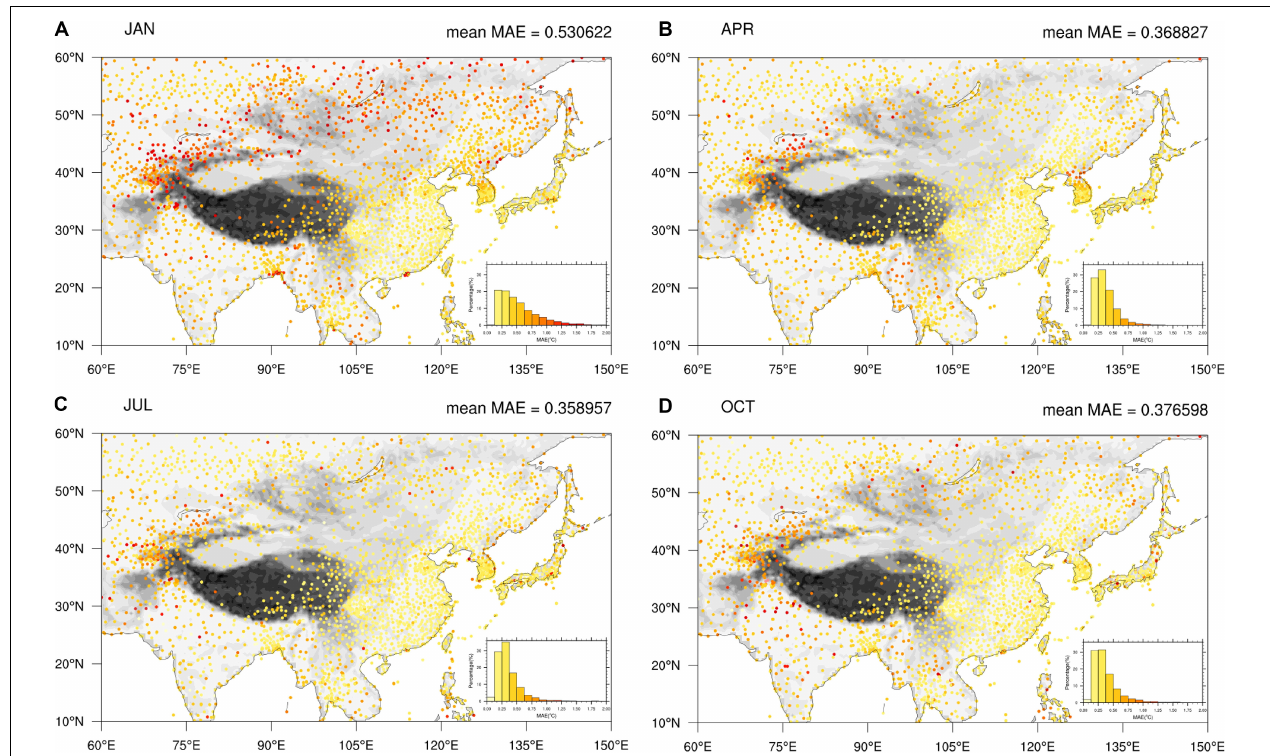
FIGURE 7 | MAEs of the LSAT anomaly over Pan-East Asian from 1900 to 2018 at each station in 4 months [January (A) , April (B) , July (C) , and October (D) ] calculated by leave-one-out cross validation.